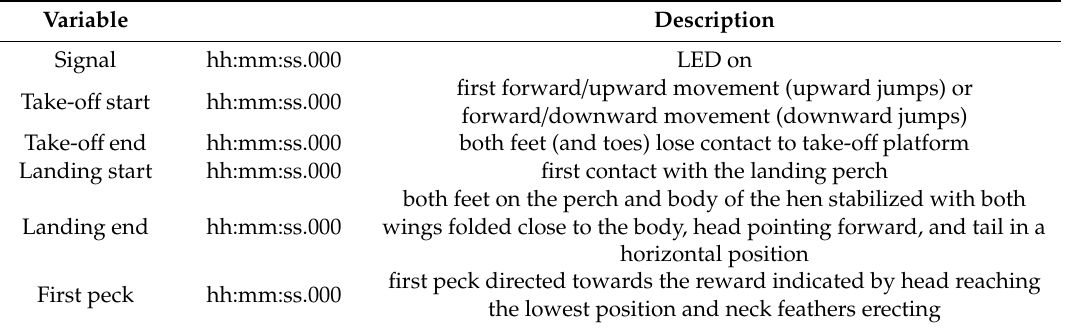
Table 1. Variables recorded from